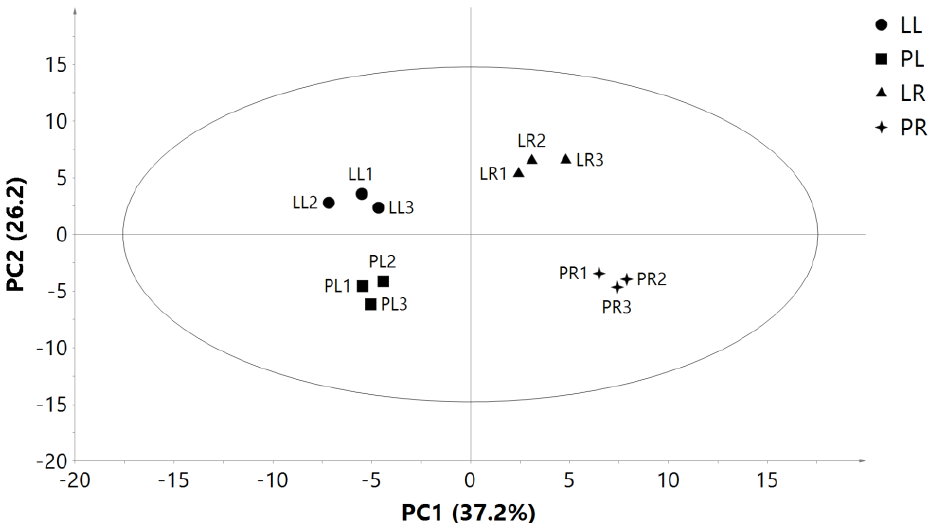
Figure 8. Principal component plot of gene expression participated in the pathway of “biosynthesis of unsaturated fatty acids” from leaves (L) and roots (R) of two purslanes ( Portulaca oleracea ) genotypes (“Pakistan” local (“PL”) and “Liaoning, China” local (“LCL”)). LL: leaves of “LCL”; PL: leaves of “PL”; LR: roots of “LCL”; PR: roots of “LCL”.